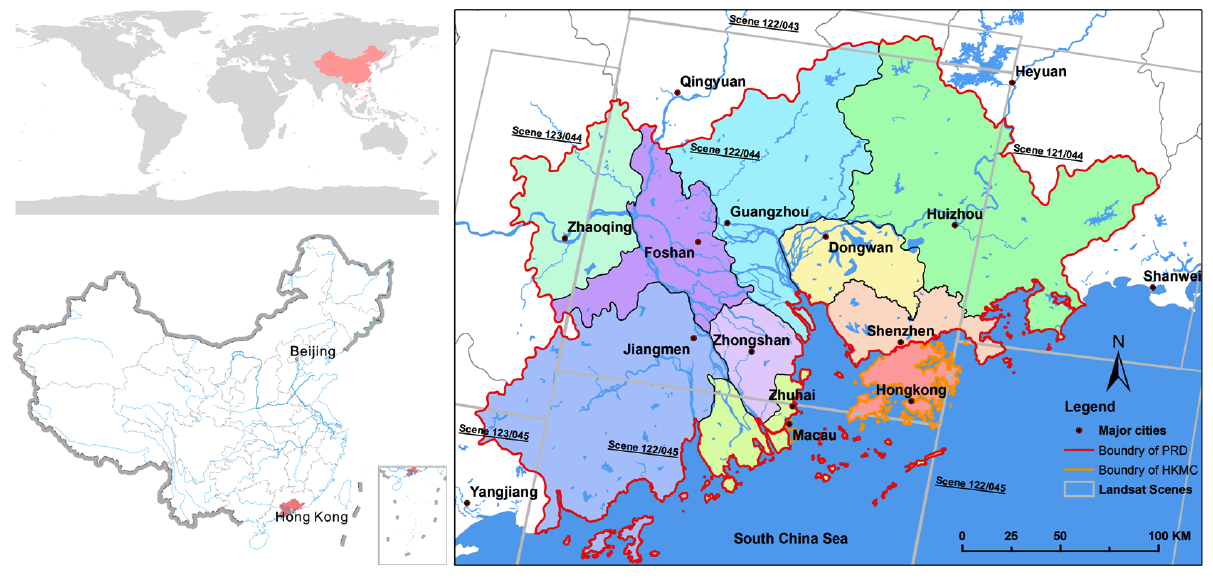
Figure 1. The Pearl River Delta (PRD)